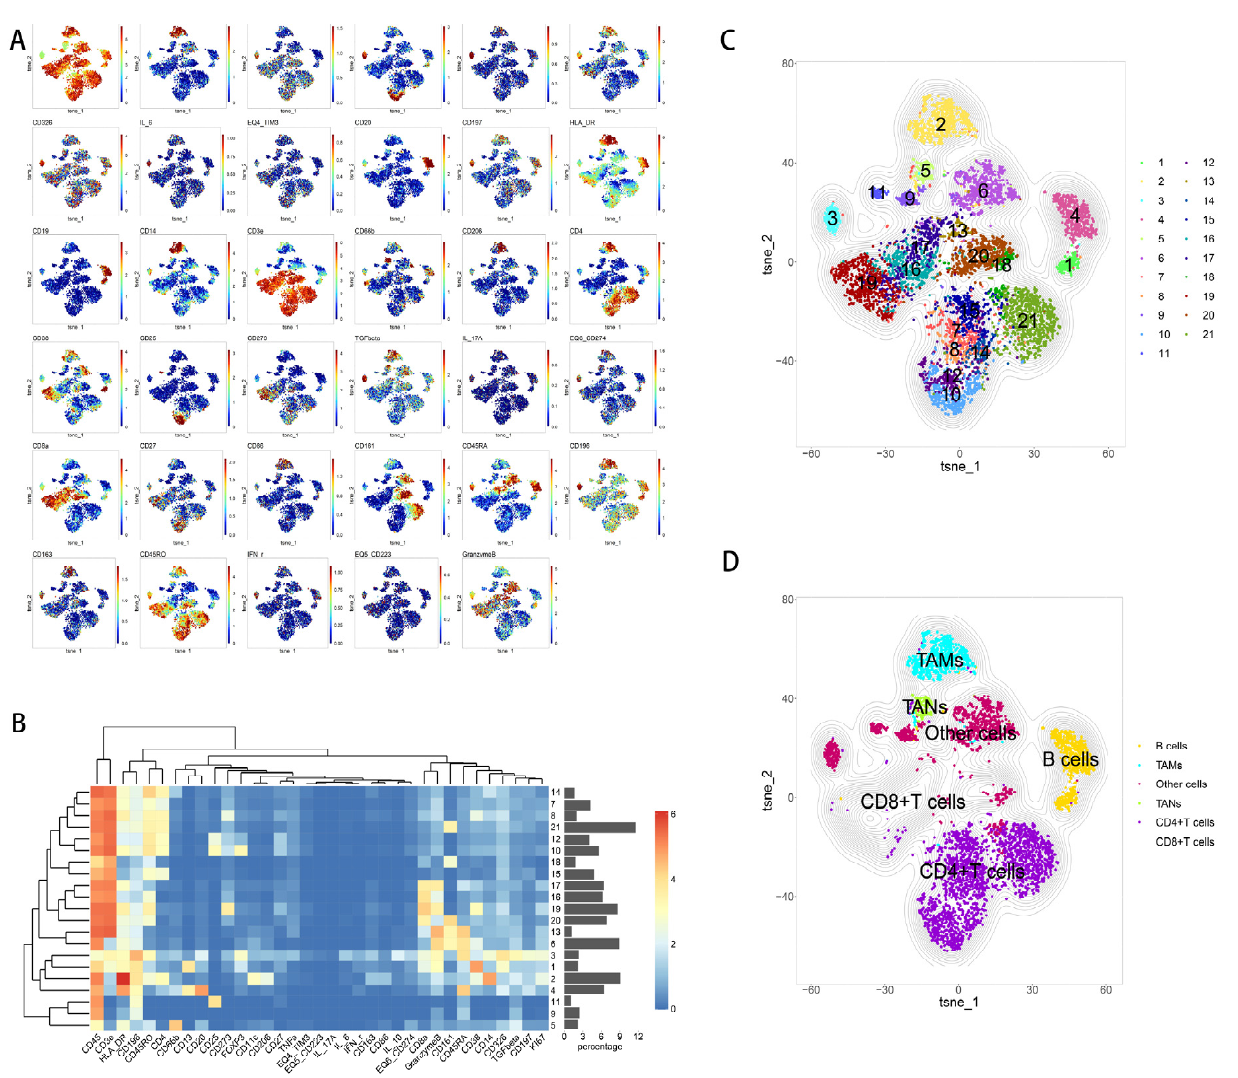
Figure 6. Expression of immune marker genes in 21 subsets of immune cells in tumors. ( A ) t-SNE diagram of the expression of each immune marker. ( B ) Heatmap of the expression of all immune- related markers after normalization. ( C , D ) t-SNE plots of immune cells that infiltrate tumor tissues. Clusters 10 and 12 contained regulatory T cells (CD3+, CD4+, CD8-, CD25+, FOXP3+).